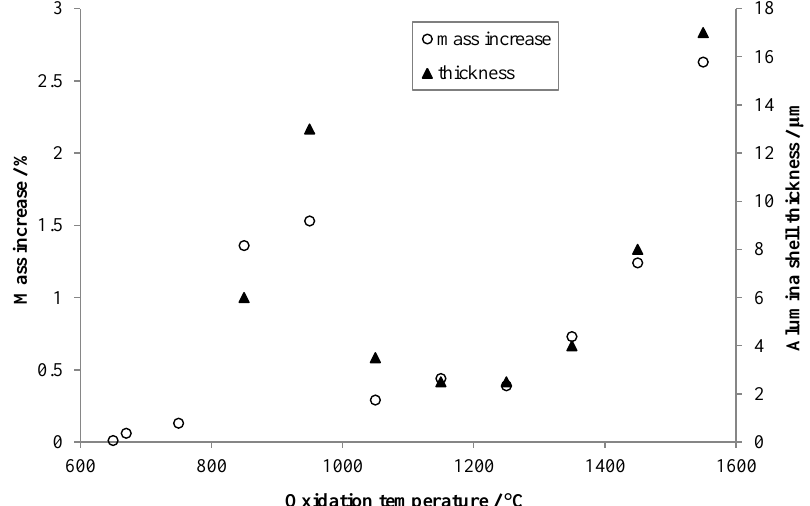
Figure 7. Thicknesses of the alumina shells estimated from the images shown in Figure 6 (filled triangles), and total mass gain during oxidation for each specimen recorded by TGA (open circles). Arbitrary scaling has been applied to both y-axes to visually align the two data sets.